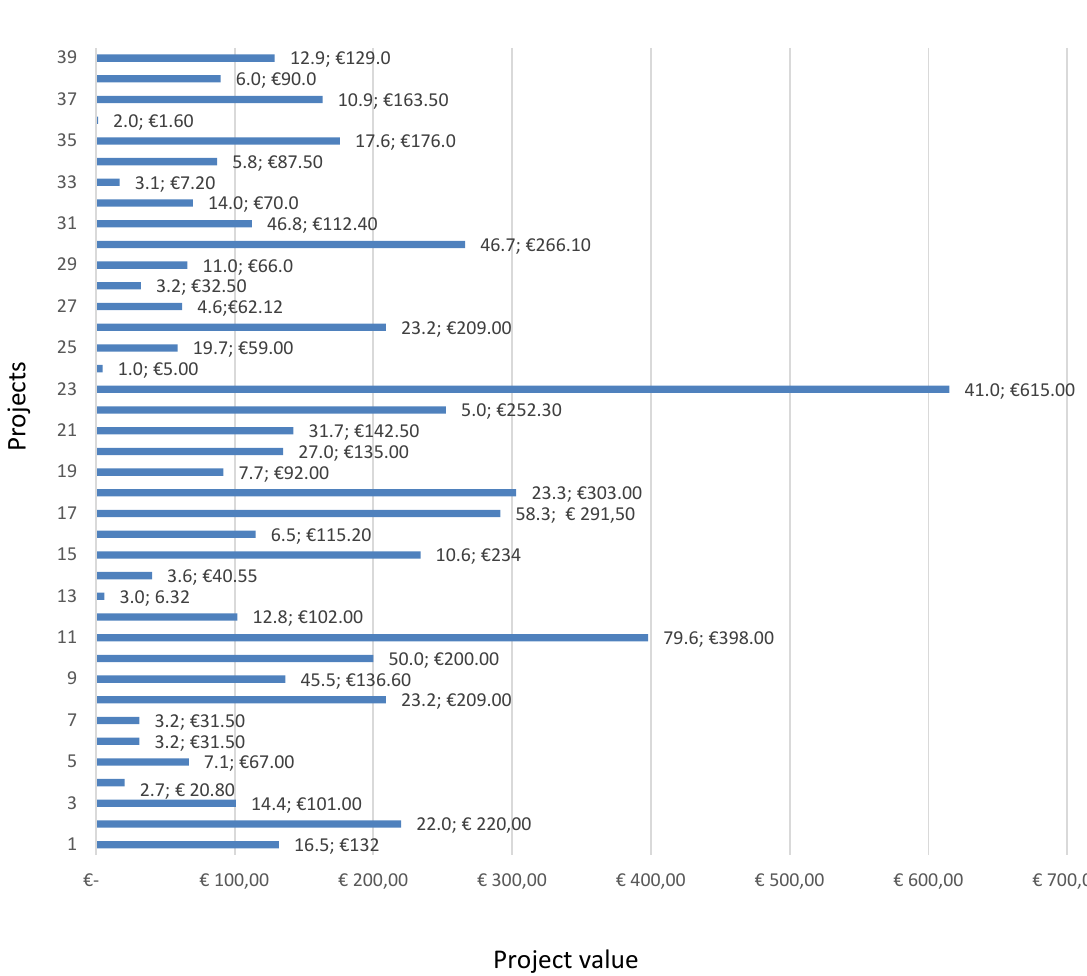
Figure 4. The leverage rate and total project cost for the EU projects